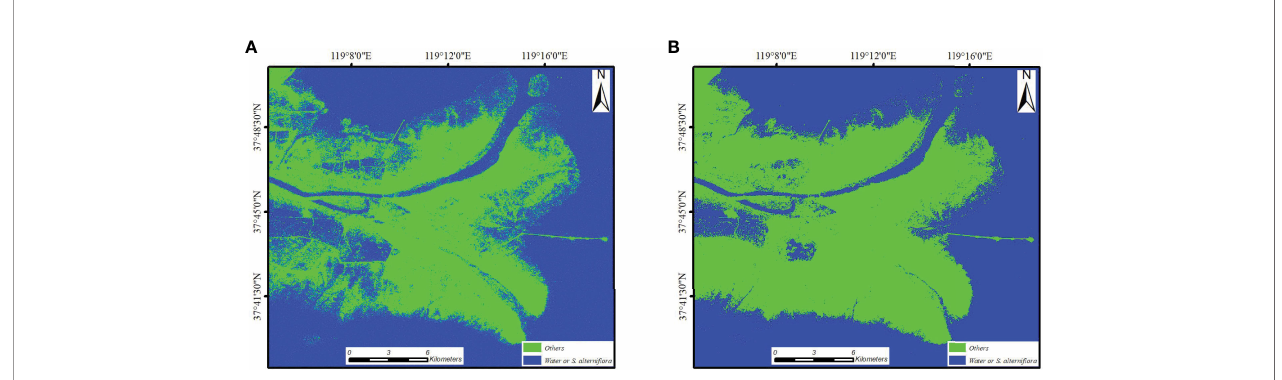
FIGURE 6 | Coherence classi fi cation map. Water and S. alterni fl ora were classi fi ed into one category, and they were distinguished from other ground objects by coherence. (A) is the coherence classi fi cation map under VH polarization, when the threshold is set as g VH < 0.32, the ground object is classi fi ed as water or S. alterni fl ora ; when the threshold is set as g VH > 0.32, the ground object is classi fi ed as others; (B) is the coherence classi fi cation map under VV polarization, when the threshold is set as g VV < 0.36, the ground object is classi fi ed as water or S. alterni fl ora ; when the threshold is set as g VV < 0.36, the ground object is classi fi ed